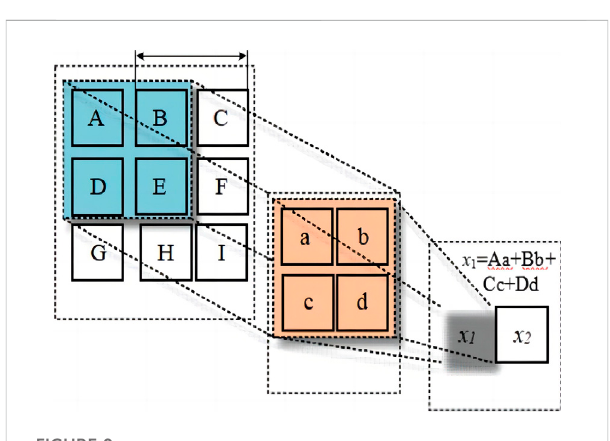
FIGURE 9 Schematic diagram of the convolution operation